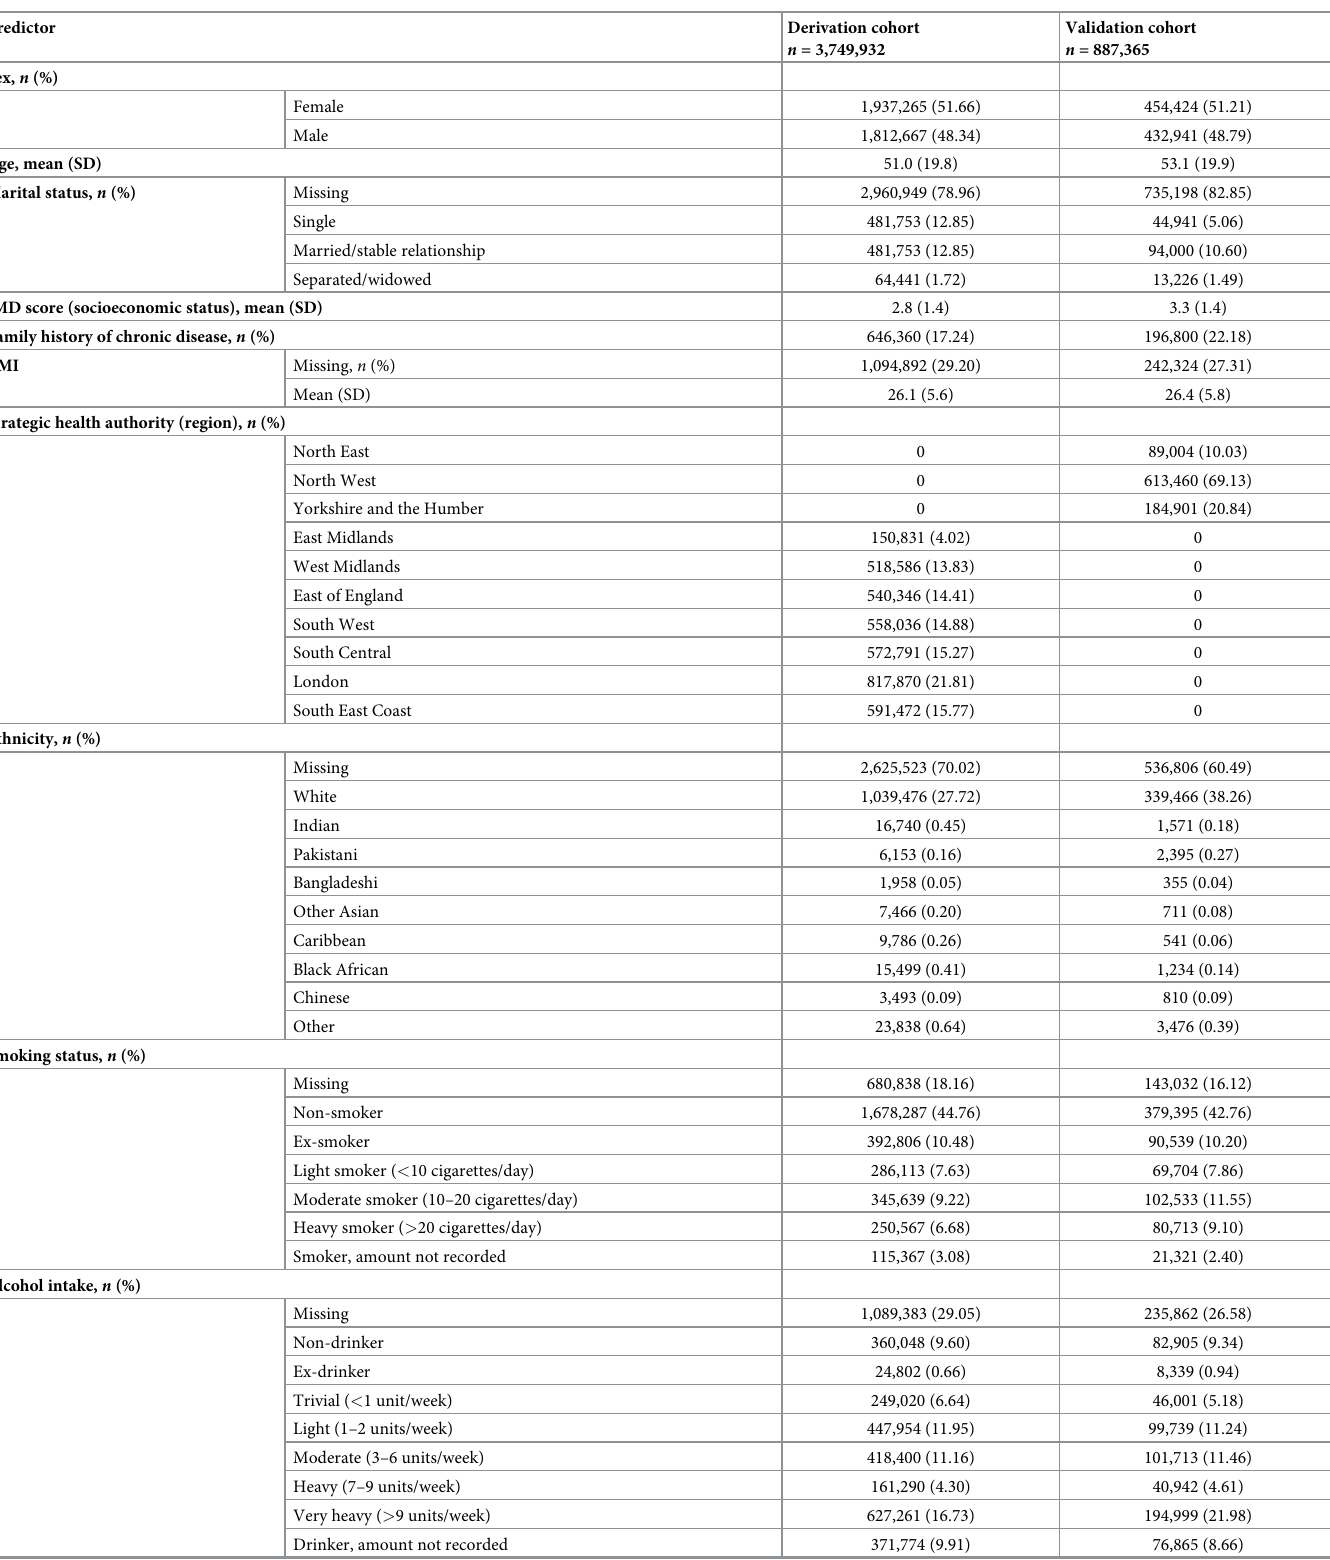
Table 2. Baseline characteristics of derivation and validation cohorts.